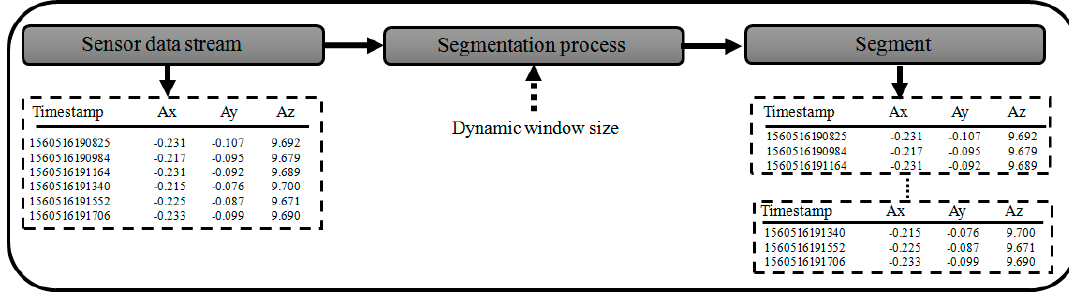
Figure 2. Overview of segmentation stages.